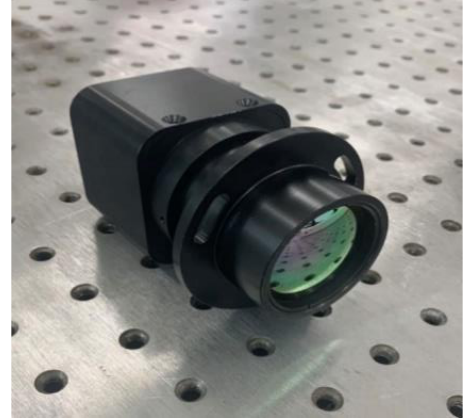
Figure 4. Assembled wide band infrared lens.